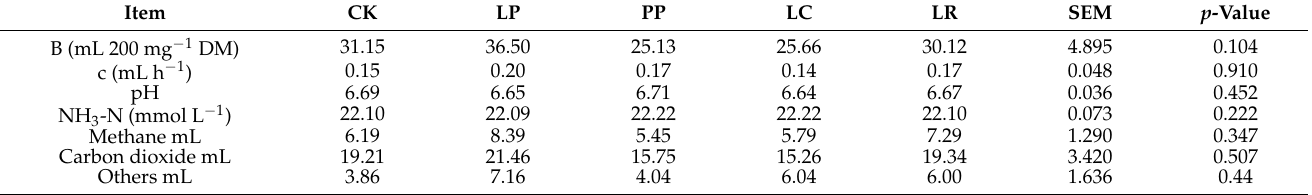
Table 6. In vitro fermentation characteristics and greenhouse gas production (72 h) of the oat